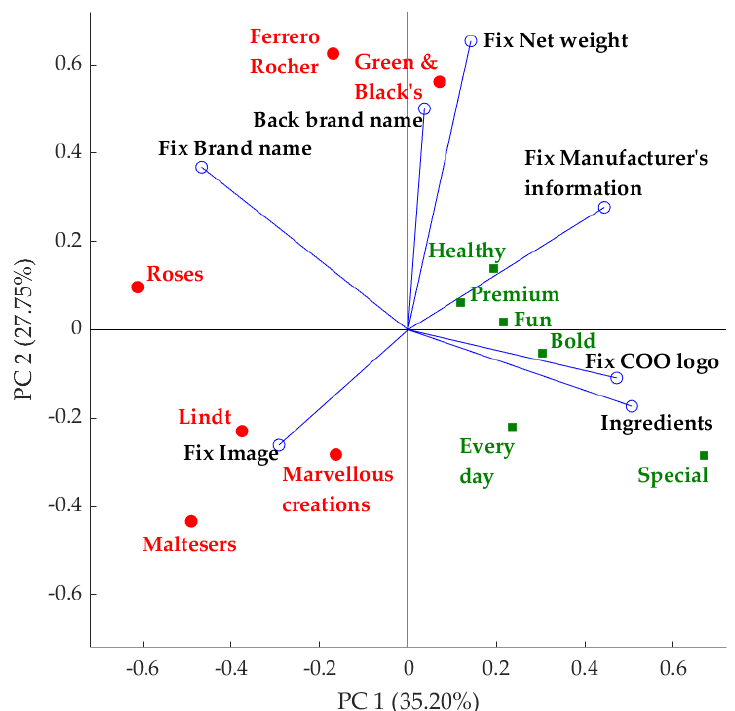
Figure 5. Results from multivariate data analysis: Principal component analysis of the number of eye ‐ tracking fixations (Fix) on AOIs against the packaging concepts. Red/circle = familiar packaging concepts and green/square = novel packaging concepts. The x ‐ axis represents the principal component 1 (PC1) while the y ‐ axis represents the principal component 2 (PC2). Abbreviations: COO, country of origin.